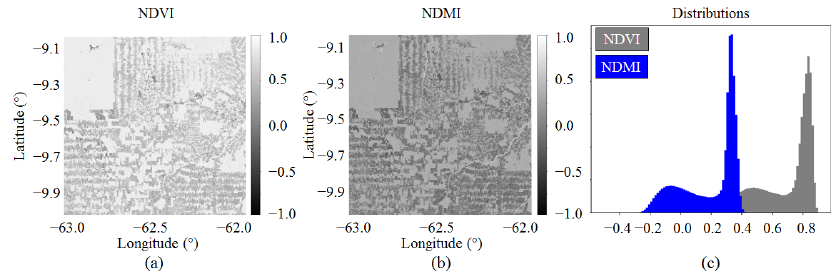
Figure 10. Example of Sentinel-2 NDVI and NDMI indexes used for the generation of the forest/non- forest validation maps. ( a ) NDVI, ( b ) NDMI and ( c ) corresponding